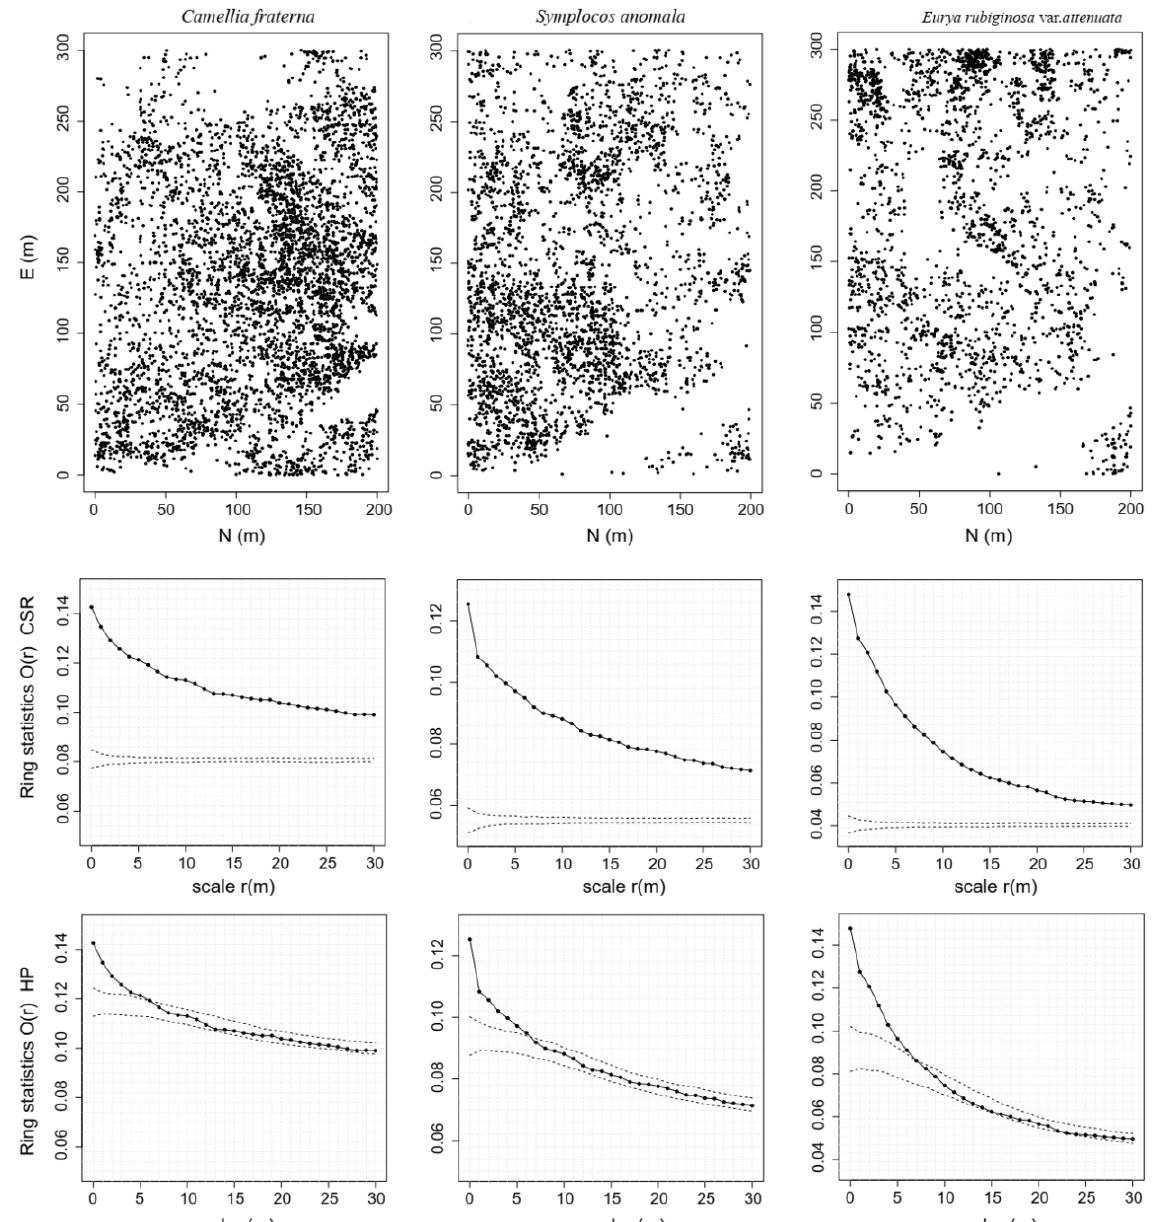
Figure 3. Spatial distribution scatter diagram and univariate point pattern analyses of Camellia fraterna , Symplocos anomala , and Eurya rubiginosa var. attenuata.